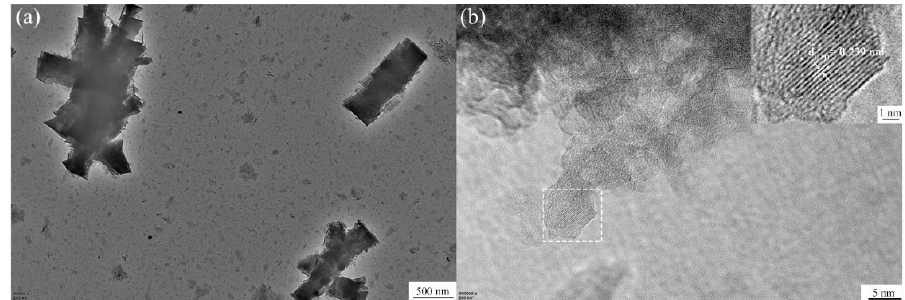
Figure 5. ( a ) TEM and ( b )HRTEM images of Al–20Si@Al 2 O 3